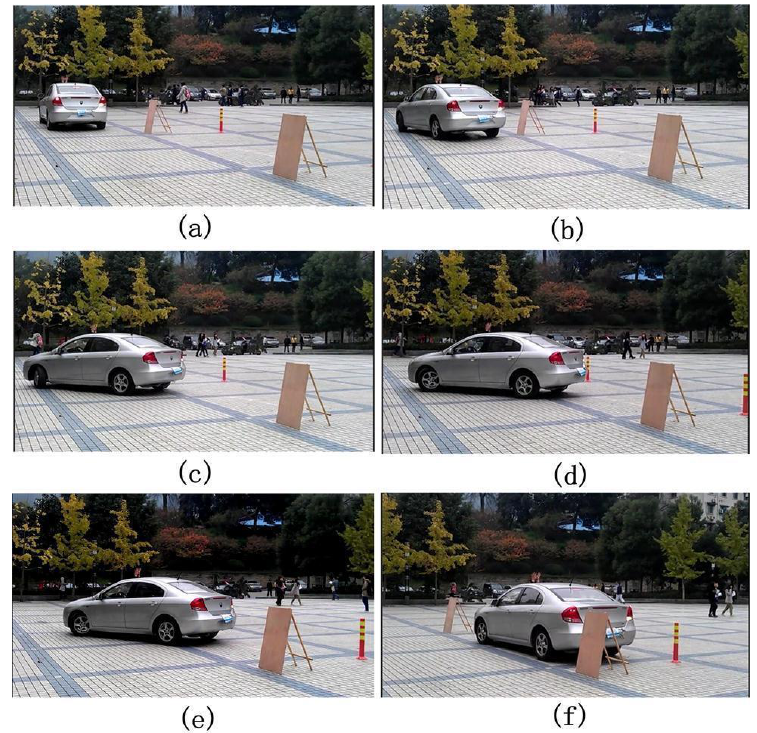
Figure 18. Parking process using proposed automatic parking system. ( a – f ) are the actual vehicle test results with different initial